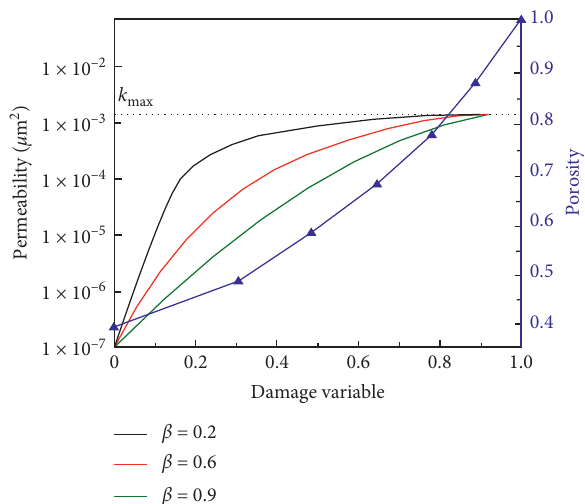
Figure 7: Relationship between porosity, permeability, and damage variables in the fractured rock mass.